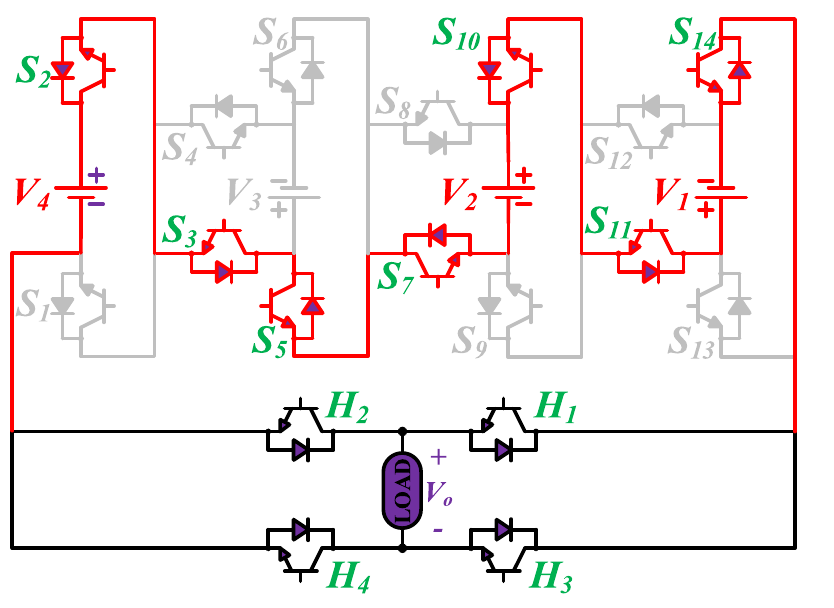
Fig 10. Switching states for voltage magnitude level